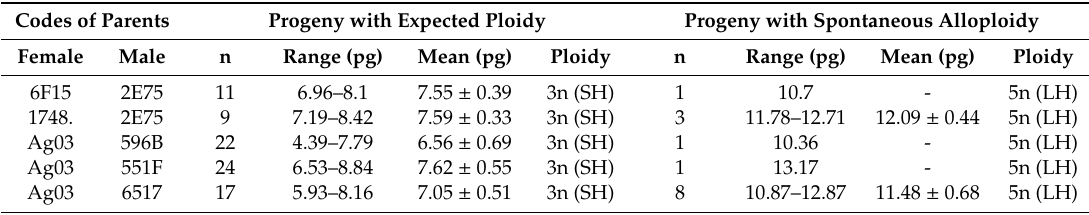
Table 1. Parents and their progenies with expected and unexpected ploidy groups. Abbreviations: SH: small genome size, LH: large genome